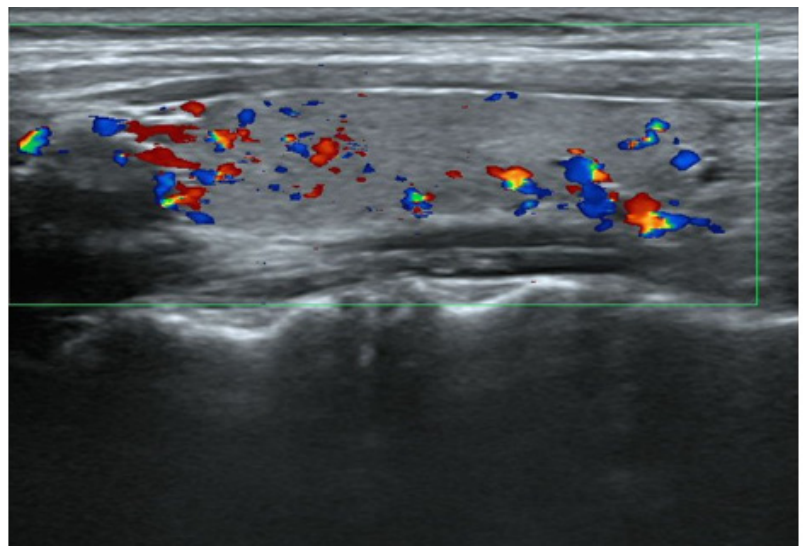
Figure 1. Thyroid US at the onset of GD. The right lobe in the sagittal view shows normal echogenicity and mild hypervascularity. The size of the right lobe was 1.18 × 1.31 × 4.32 cm (volume 3.5 cm 3 ) and within normal range.